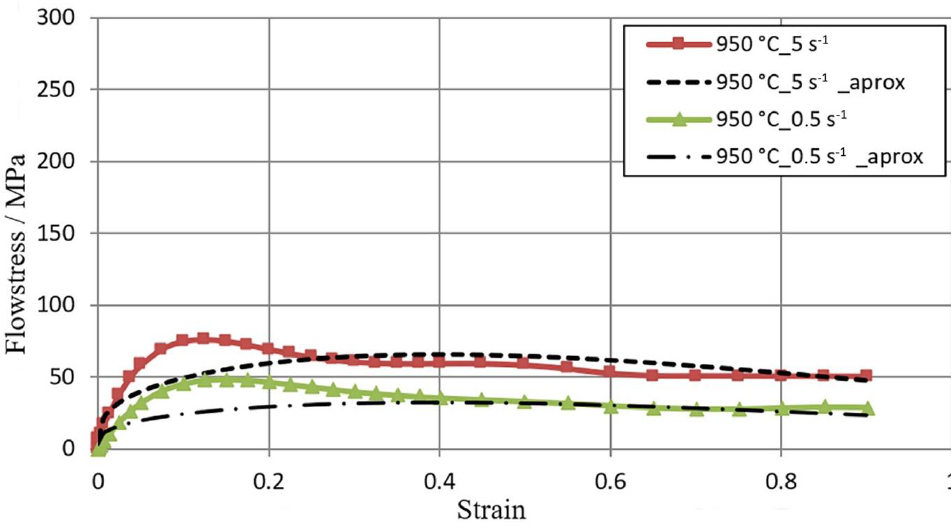
Figure 7. σ p − ε M5 alloy flow curves obtained for the temperature T = 950 ◦ C in the range of ´ ε Figure 7. σ p − Ɛ M5 alloy flow curves obtained for the temperature T = 950 °С in the range of έ strain strain rate from 0.5 to 5.0 s − 1 using the Gleeble metallurgical process simulator 3800; (1) continuous rate from 0.5 to 5.0 s −1 using the Gleeble metallurgical process simulator 3800; (1) continuous lines — lines—experimental data; (2) dashed lines—data after experimental data; (2) dashed lines — data after approximation.